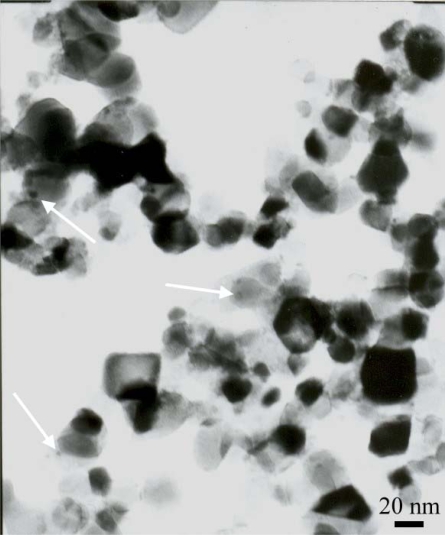
TEM image of 2.0 wt% Ag in TiO2 nanoparticles. Some of Ag nanoparticles were indicated by the arrows.